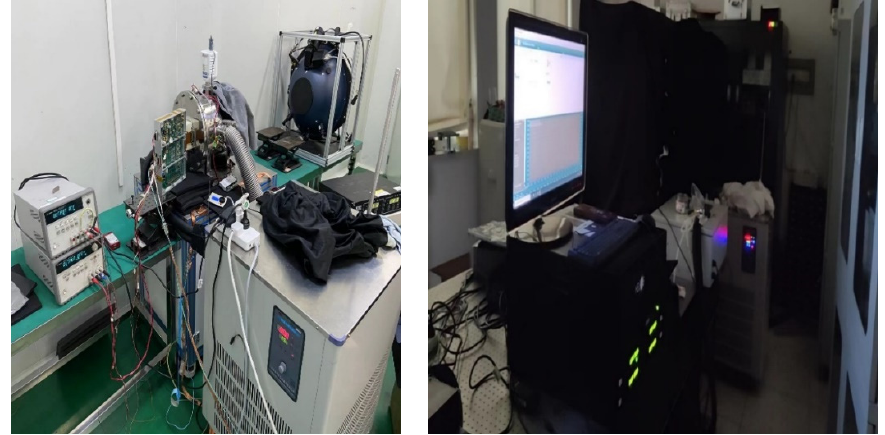
Figure 15. Physical picture of camera test system.